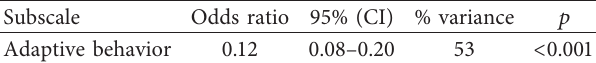
Table 3: Predicting ASD diagnosis based on adaptive behavior scale standard deviation.